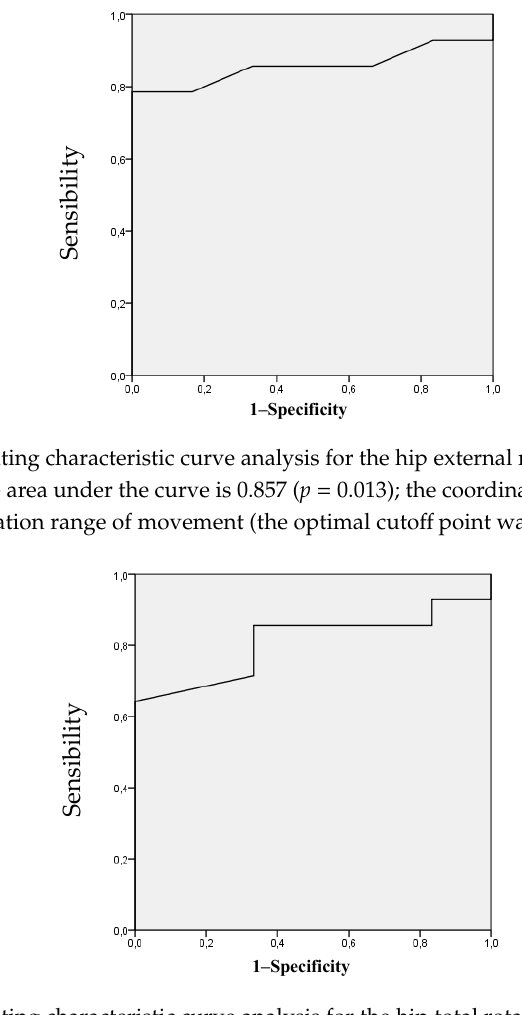
Figure 3. Receiver operating characteristic curve analysis for the hip total rotation ROM as a risk factor for lower back pain. The area under the curve is 0.810 ( p = 0.032); the coordinates represent possible cutoff point in hip total rotation range of movement (the optimal cutoff point was 93°).